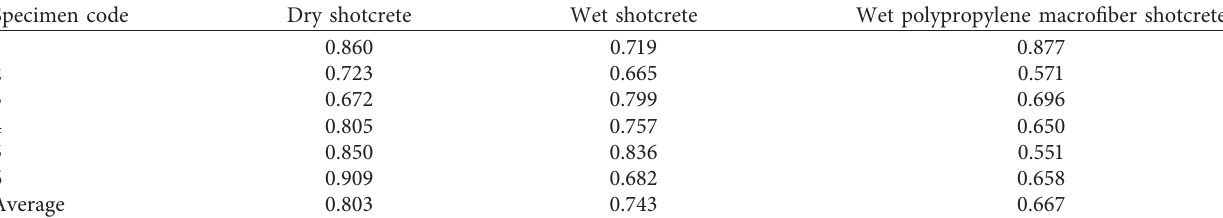
Table 3: Initial strength attenuation coefficients of three different shotcrete